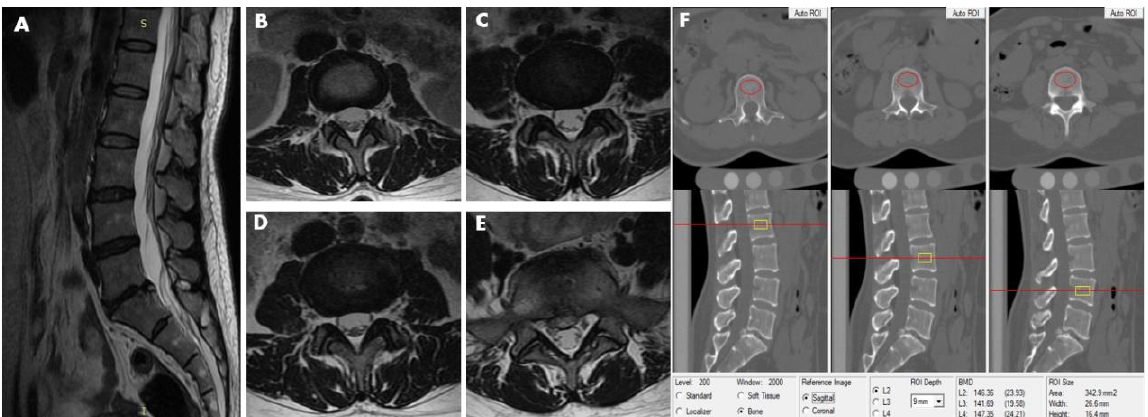
Figure 2. This 40-year-old female participant was assigned to the LDH group and subgroup 1. MRI (T2-weighted image) revealed lumbar disc herniation condition from L2–3 to L5–S1disc. ( A ) Sagittal image revealed lumbar disk herniation in the level of L5–S1. ( B ) L2–3 axial image shows no abnormality in disc morphology. ( C ) L3–4 axial image showns no abnormality in disc morphology. ( D ) Also, the L4–5 axial image shows no abnormality in disc morphology. ( E ) L5–S1 axial image show focal protrusion at the central canal zone with a high-intensity zone (HIZ). ( F ) The measurements of L2, L3, and L4 vertebral trabecular volumetric bone mineral density (Trab.vBMD) are shown; the BMD of L2, L3, and L4 is 146.36 mg/cm 3 , 141.69 mg/cm 3 and 147.35 mg/cm 3 , respectively. The average lumbar Trab.vBMD is 145.13 mg/cm 3